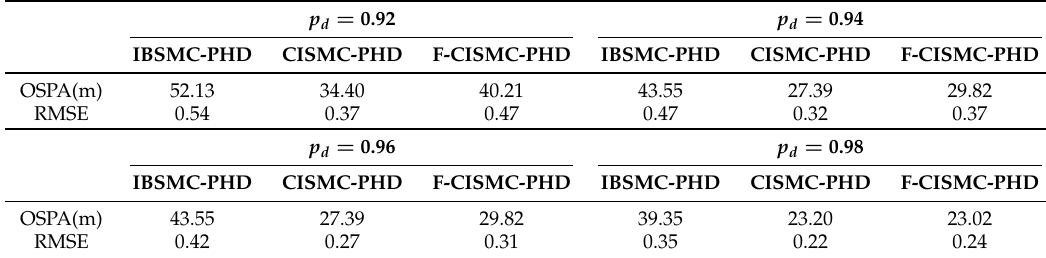
Table 6. Tracking Performance over different detection probabilities.